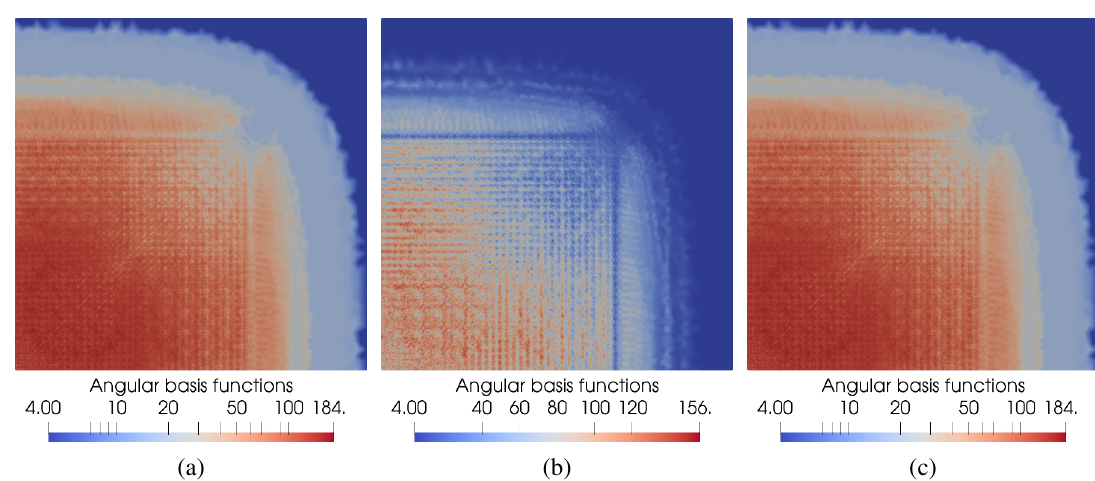
Figure 2: Plots indicating the number of angular basis functions present across the spatial mesh, normalised to one energy group. (a) Energy independent angular adaptivity. (b-c) Energy dependent angular adaptivity split across 2 energy group sets (b) “Fast” energy groups (c) “Thermal” energy groups